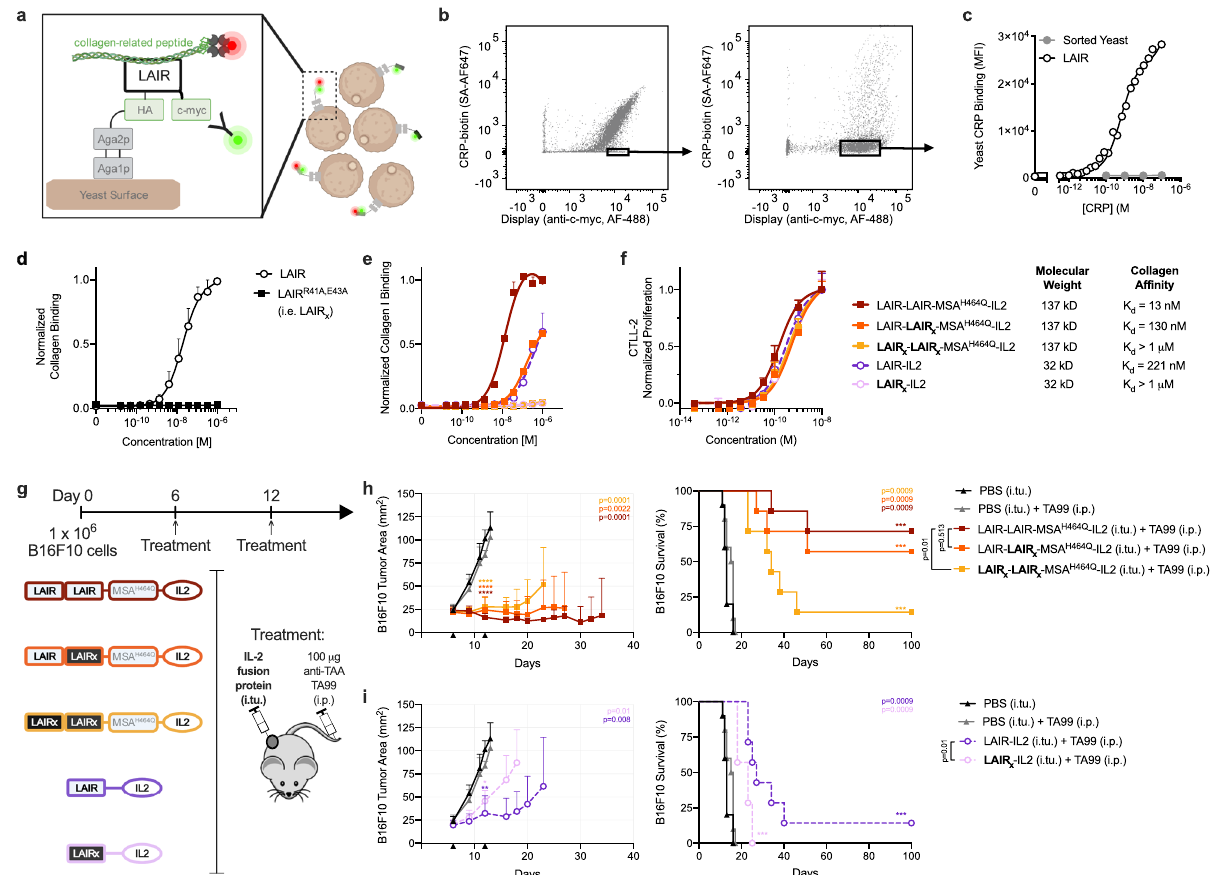
Fig. 1 Molecular weight and collagen af fi nity are key determinants of IL-2 ef fi cacy. a Schematic of yeast library displaying mutagenized-LAIR (white) as Aga2 (gray) fusion proteins. LAIR expression was detected using a fl uorescent antibody against c-myc epitope (green) and binding to biotinylated collagen-related peptide (CRP) was detected using fl uorescent streptavidin (SA-AF647, red). b Successive fl ow assisted cells sorts isolating LAIR mutants with diminished binding to biotinylated CRP. c Equilibrium binding titration of biotinylated CRP on enriched yeast from panel b (mean + s.d.; n = 8) compared to wild-type LAIR-displaying yeast ( n = 1). Binding was measured by median fl uorescence intensity of SA-AF647 by fl ow cytometry. d LAIR and LAIR R41A E43A , henceforth LAIR x , binding to collagen measured by enzyme-linked immunosorbent assay (ELISA) (mean + s.d., n = 6 for LAIR and n = 3 for LAIR x ). e Collagen binding af fi nity ( K d , equilibrium dissociation constant) of IL-2 fusion proteins in small and large molecular weight formats (kD, kilodaltons) measured by ELISA (mean + s.d; n = 3 for all groups except n = 6 for LAIR-IL2). f Dose-dependent proliferation of CTLL-2 cells exposed to IL-2 fusion proteins (mean + s.d.; n = 3) g Schematic of B16F10 tumor study timeline (top) and treatment components (bottom). Mice were inoculated with 1 × 10 6 B16F10 cells subcutaneously in the right fl ank on day 0. Treatments were administered on day 6 and 12. TAA, tumor-associated antigen; i.tu., intratumoral; i.p., intraperitoneal. h , i Tumor growth (left, mean + s.d.) and survival (right) over time ( n = 10 mice for the PBS (i.tu.) and PBS (i.tu.) + TA99 (i.p.) groups, and n = 7 mice for all other groups). Tumor area is shown until a mouse in the group is euthanized. Statistical signi fi cance of each treated group ’ s tumor area and survival (top right corner) was calculated by using a one-tailed Student ’ s t -test and log-rank Mantel-Cox test, respectively, versus the PBS (i.tu.) + TA99 (i.p.). Other survival comparisons (legend adjacent) were generated by a log-rank Mantel-Cox test. * P < 0.03; ** P < 0.002; *** P < 0.0002; **** P < 0.0001; n.s. not signi fi cant. Source data for panel c – f and h , i are provided in the Source Data fi le. Panels a and g created with